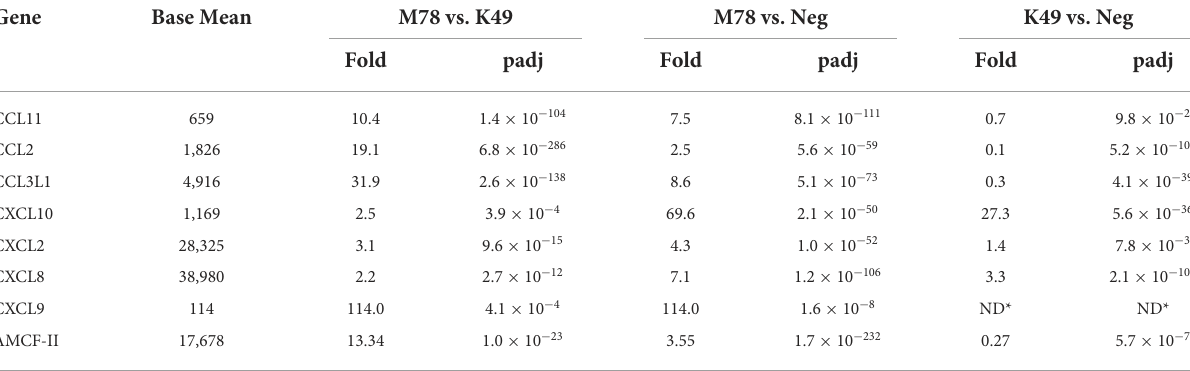
TABLE 6 Differential expression of chemokine genes in PBMCs infected with ASFV strains K49 or M78 (FDR ≤ 0.05). Gene Base Mean